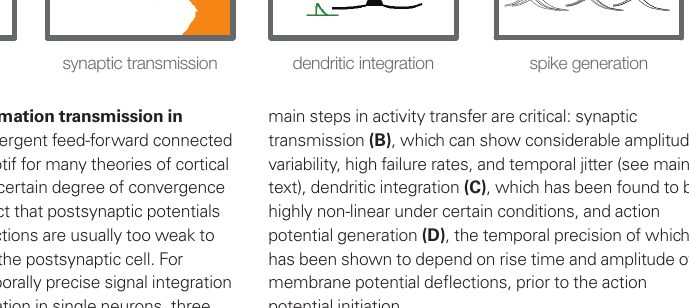
main steps in activity transfer are critical: synaptic transmission (B) , which can show considerable amplitude variability, high failure rates, and temporal jitter (see main text), dendritic integration (C) , which has been found to be highly non-linear under certain conditions, and action potential generation (D) , the temporal precision of which has been shown to depend on rise time and amplitude of membrane potential deflections, prior to the action potential